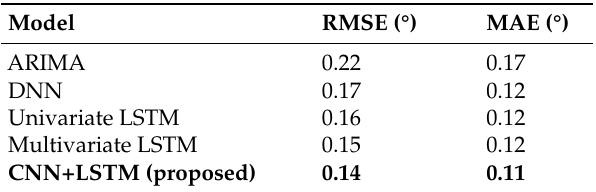
Table 2. RMSEs and MAEs of each model at “JingHai-VI” test set-1. ARIMA: autoregressive integrated moving average; DNN: deep neural